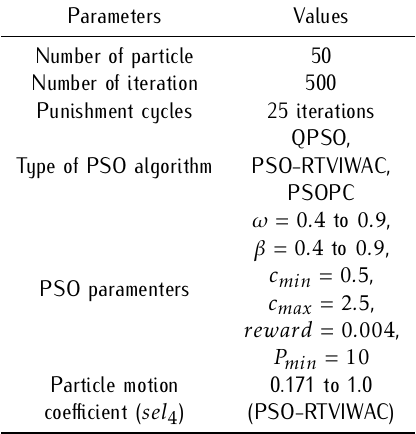
Table 2. Summary of simulation parameters